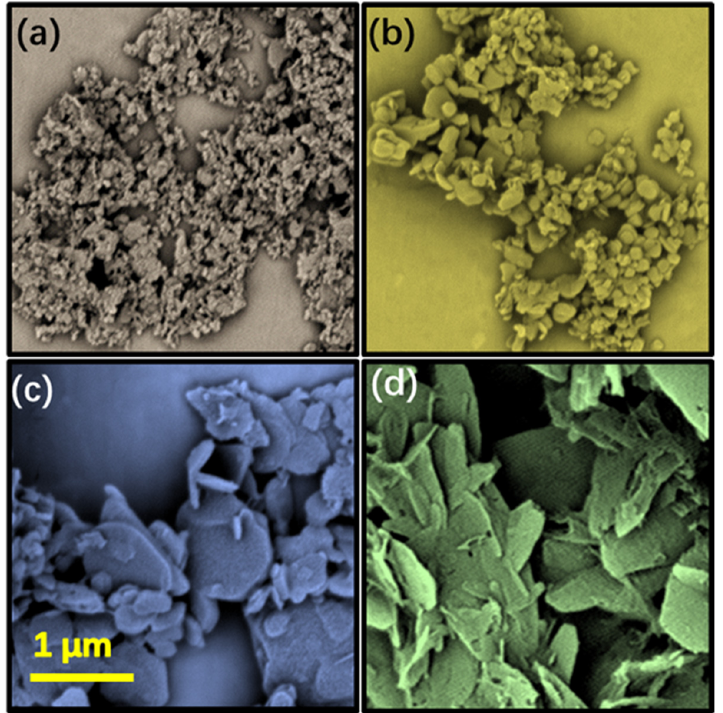
Figure 2. SEM images of BN synthesized with different molar ration of boric acid to ureal ( a – d were 1:2, 1:4, 1:8 and 1:16, respectively).